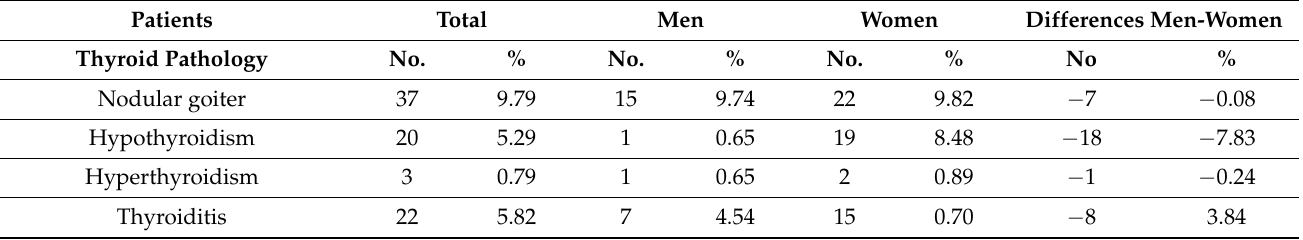
Table 4. Thyroid dysfunctions identified in patients.